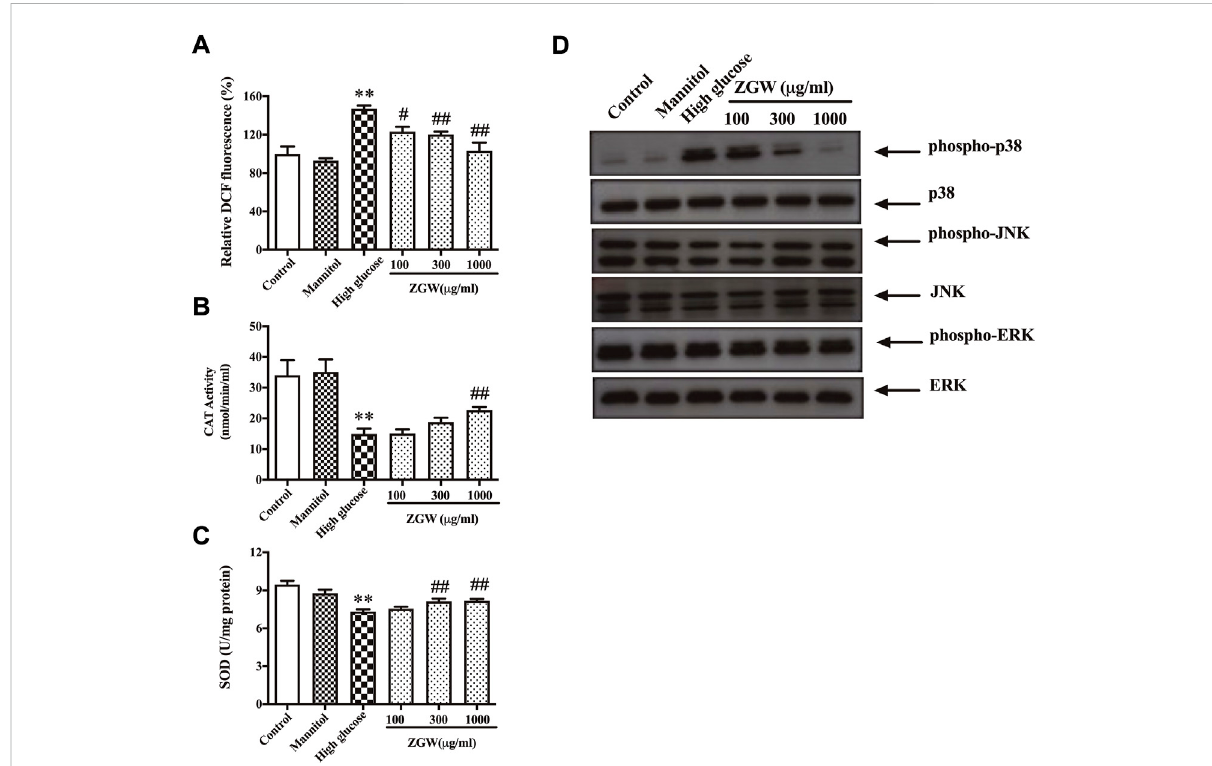
FIGURE 6 ZGW dose-dependently inhibited high glucose-induced ROS generation, elevated CAT, SOD, and regulated p38 MAPK in podocytes. Podocytes were preincubated with 100, 300, and 1,000 μ g/ml ZGW for 1 h and then exposed to normal, mannitol (5 mM glucose and 25 mM mannitol),andhighglucose(30 mM).TheeffectsofZuoguipillonROSweredeterminedby (A) DCF-DAstaining.TheeffectofZuoguipillon (B) CAT and (C) SOD was detected by ELISA. (D) Representative immunoblots of MAPK signaling. Statistical analysis was performed with one-way ANOVA and the Newman – Keuls multiple comparison test. ** p < 0.01, compared with the control group. # p < 0.05, ## p < 0.01 compared with high glucose.